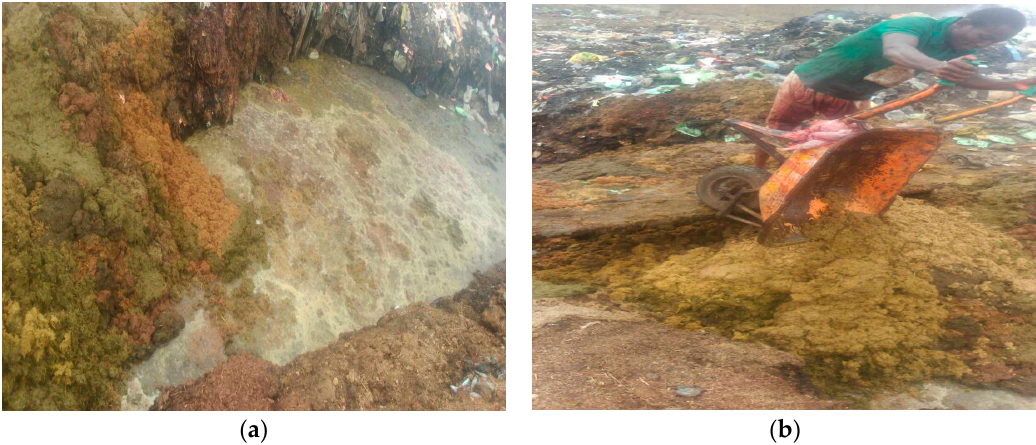
Figure 4. Waste from Suleja abattoir dumped at a nearby stream. ( a ) Waste dumped at nearby stream; ( b ) Dumping of